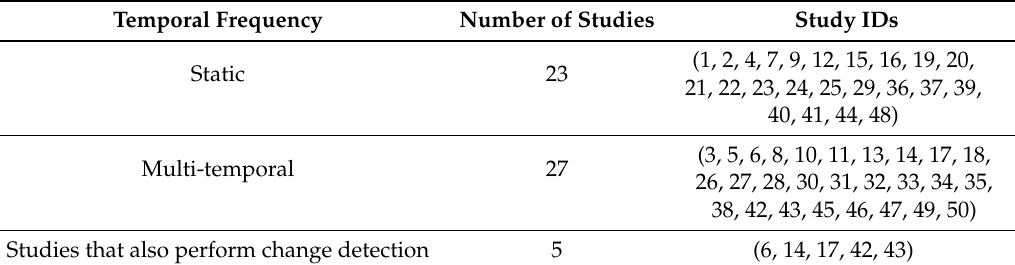
Summary of whether analyses are conducted on static or multi-temporal data in land use-related studies.